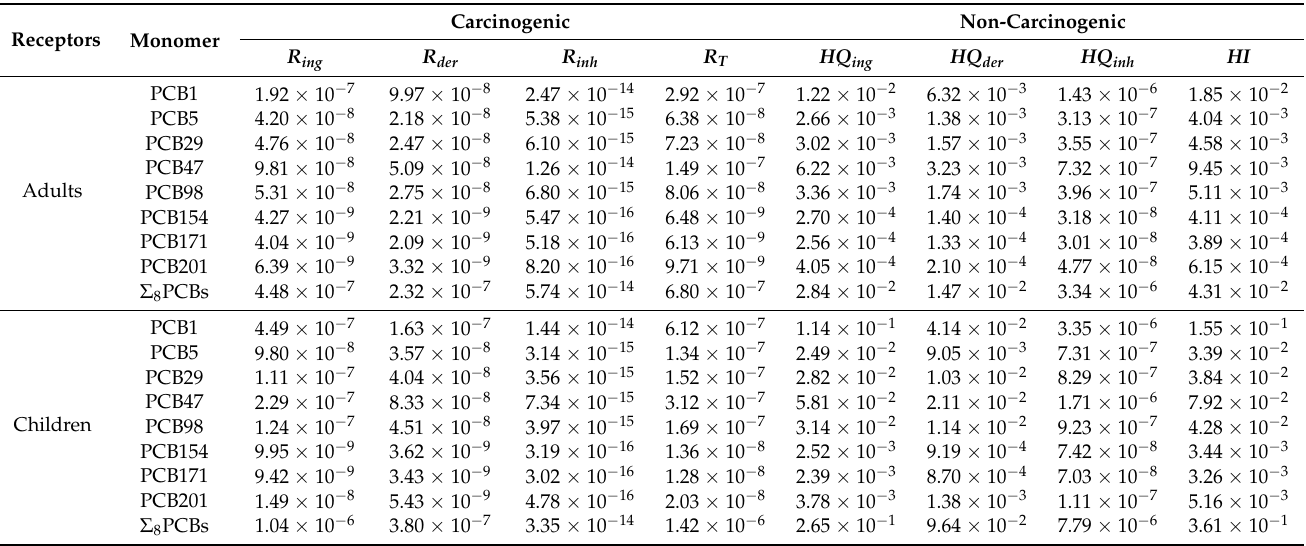
Table 6. Carcinogenic and non-carcinogenic risks of PCBs in 20–40 cm soil.